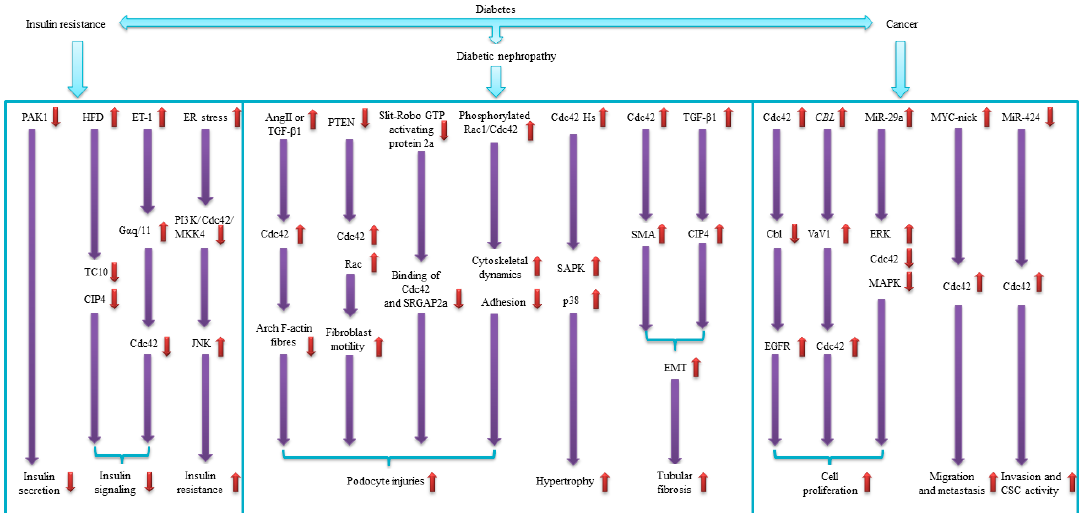
Figure 2. Cdc42 and diabetes associated diseases. This figure depicts the signaling pathways that Cdc42 may impact diabetes associated diseases including insulin resistance, diabetic nephropathy and diabetic cancer. Arrows in purple point to downstream factors, and arrows in red refer to regulation of them. The up (down) arrow in red indicates that the corresponding factor is up-regulated (down-regulated).